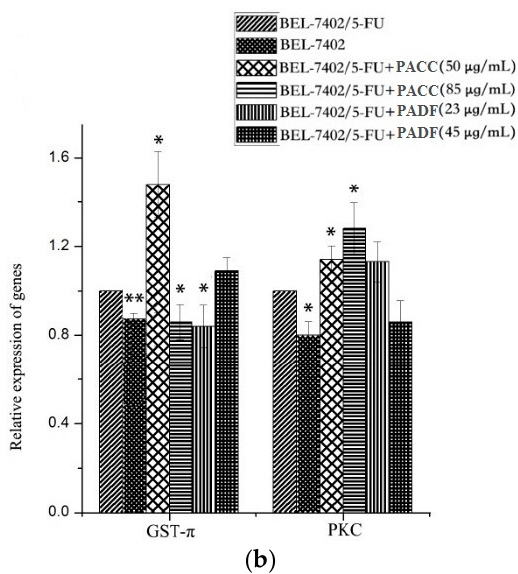
Figure 7. The relative expression of PACC and PADF on multidrug resistance-associated genes; Values are presented by mean ± SD ( n = 6). ( a ) Effects of PACC and PADF from P. americana on the expression of multidrug resistance-associated genes; ( b ) Effects of PACC and PADF from P. americana on the gene expression of multidrug resistance-associated enzymes. * p < 0.05, ** p < 0.01 vs. BEL-7402, ▲ p < 0.05, ▲▲ p < 0.01 vs. PACC.